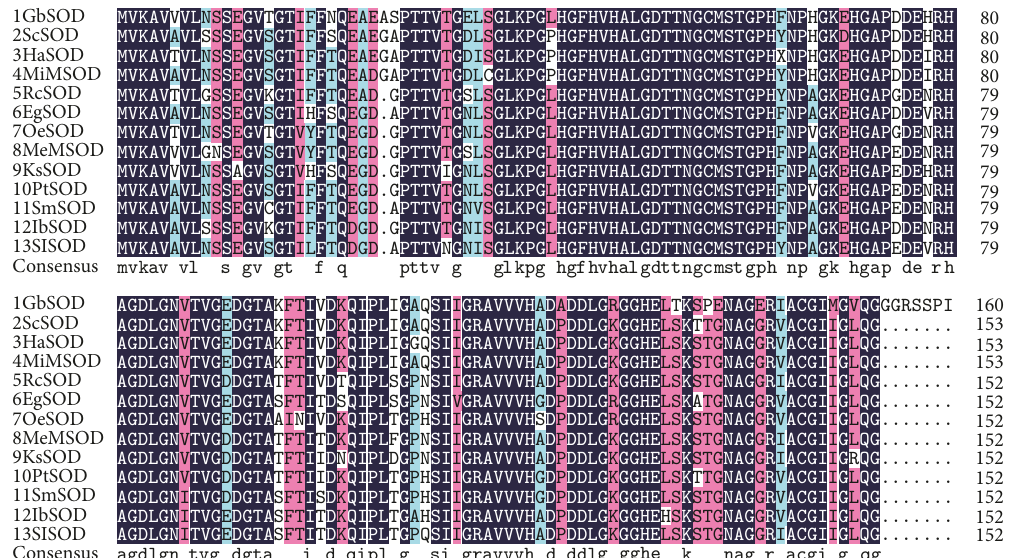
Figure 2: Multiple alignment with other plant species: (1) G. bicolor ; (2) Solidago canadensis (gi | 3914998 | sp | O04996.3 | ); (3) Helianthus annuus (gi | 50978416 | emb | CAH06454.1 | ); (4) Mikania micrantha (gi | 269856434 | gb | ACZ51444.1 | ); (5) Ricinus communis (gi | 255542450